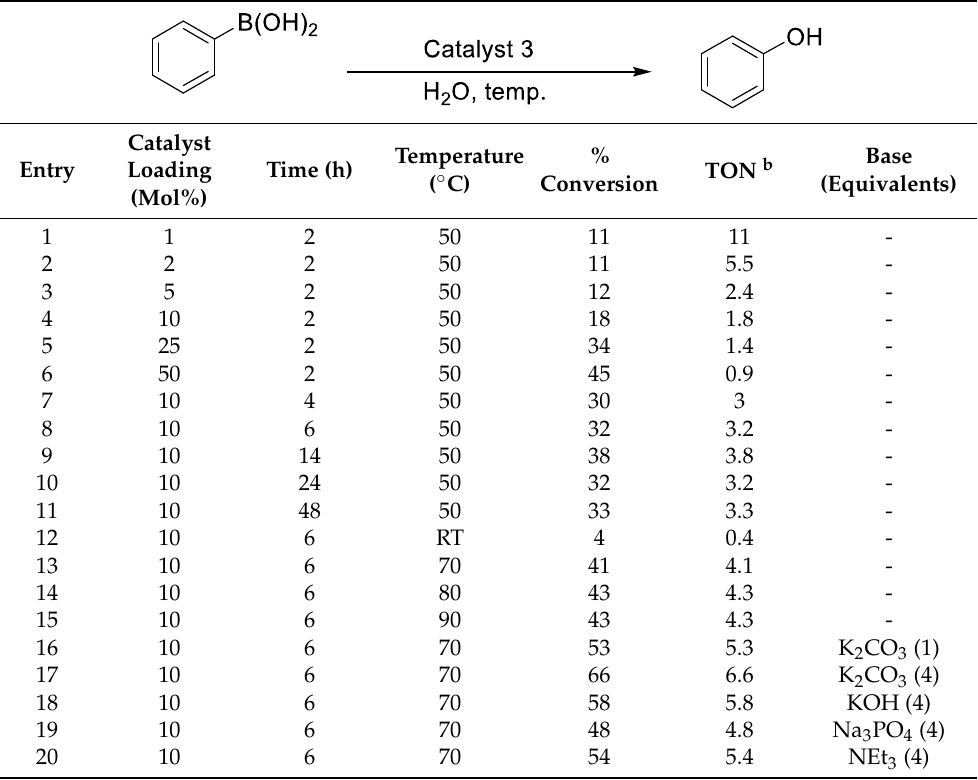
Table 1. Optimization of reaction conditions for complex 3 catalyzed formation of phenol from phenylboronic acid a